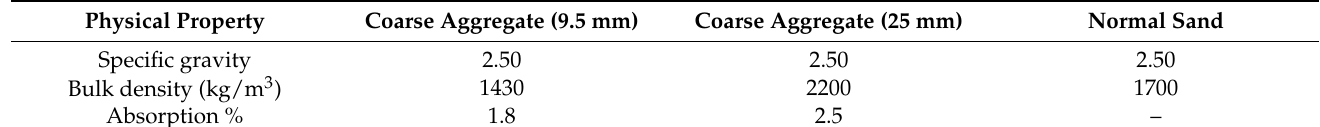
Table 3. Physical characteristics of aggregates used.